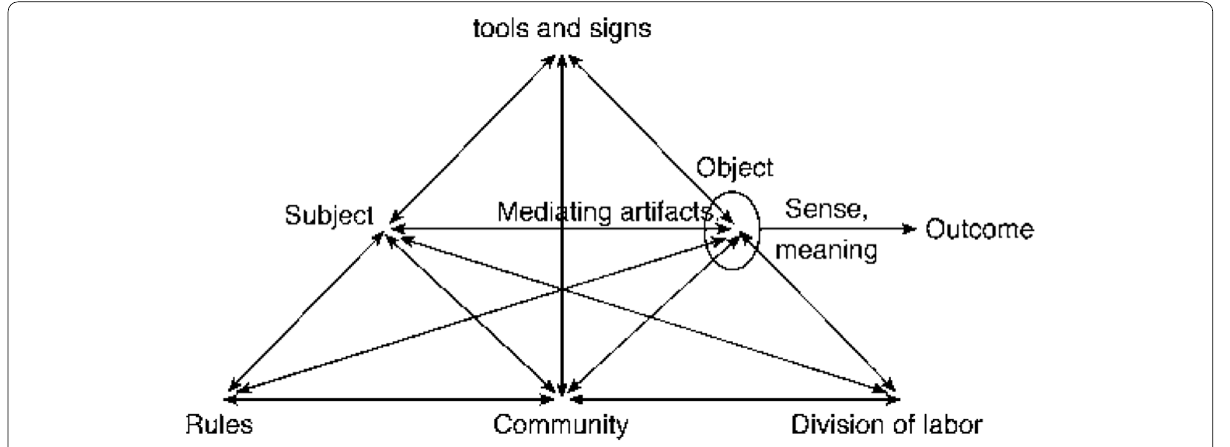
Fig. 1 The structure of a human activity system (Engeström, 2001, p.